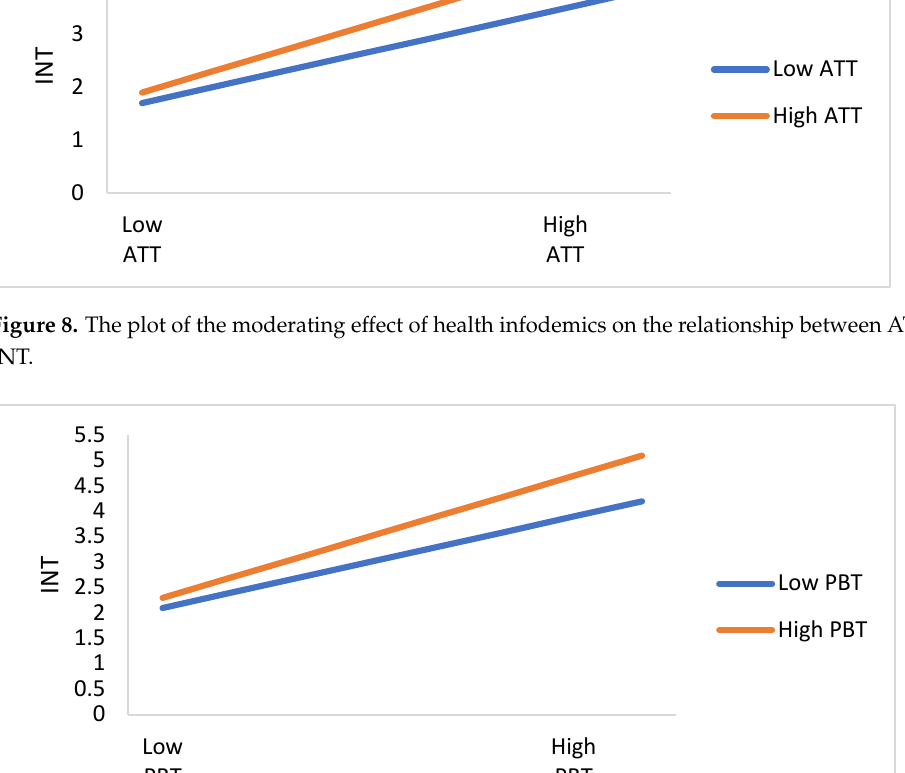
Figure 9. The plot of the moderating effect of health infodemics on the relationship between PBT and INT.